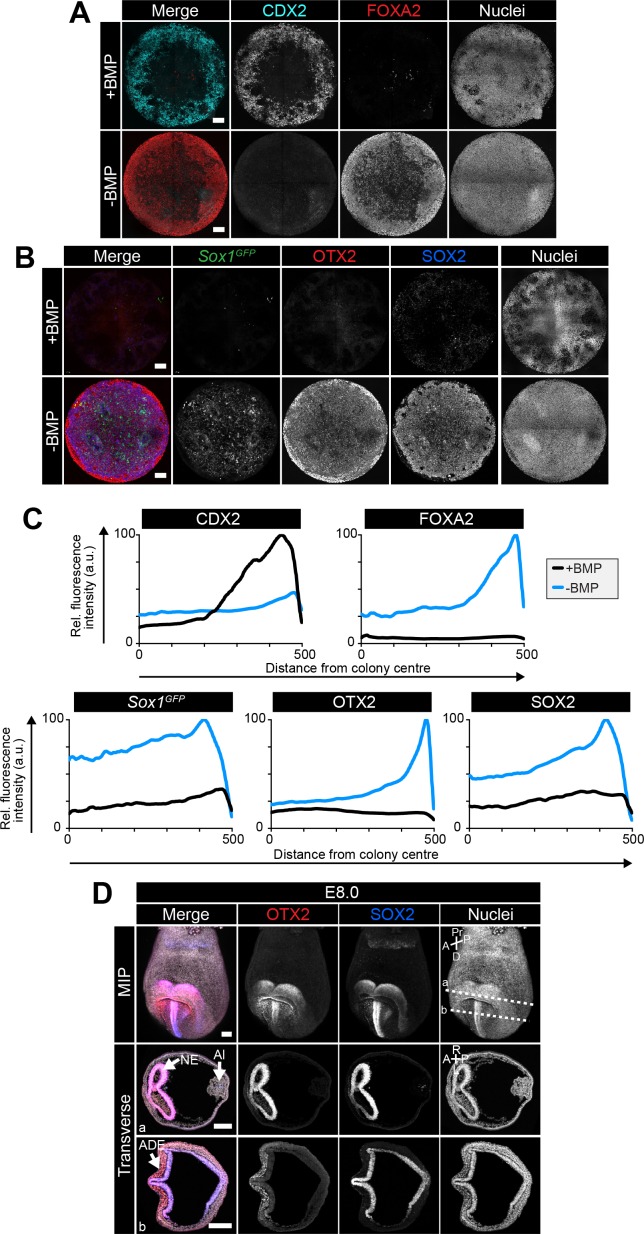
An anterior epiblast/neurectoderm population is formed in the absence of BMP.Sox1GFP/+ EpiLCs generated as in Figure 1C were plated overnight onto Laminin-coated micropatterns (−24 hr) in N2B27 medium with F/A. Various conditions were used for further differentiation - F/A, BMP4, WNT3A (+BMP) or F/A, WNT3A (-BMP). Colonies were analyzed after 72 hr differentiation. (A,B) MIPs of immunostained 72 hr colonies. Sox1GFP/+ cells were stained with an anti-GFP antibody. Scale bars, 100 μm. (C) Quantification of immunostaining. Voxel fluorescence intensity was measured from colony center (0) to edge (500). Data represents average voxel intensity across multiple colonies relative to maximum voxel intensity for each marker. n = 10. (D) Confocal maximum intensity projections (MIP) and transverse cryosections of an E8.0 mouse embryo. Dashed lines mark transverse plane. Al, allantois; NE, neurectoderm; ADE, anterior definitive endoderm; A, anterior; P, posterior; Pr, proximal; D, distal; L, left; R, right. Scale bars, 100 μm.